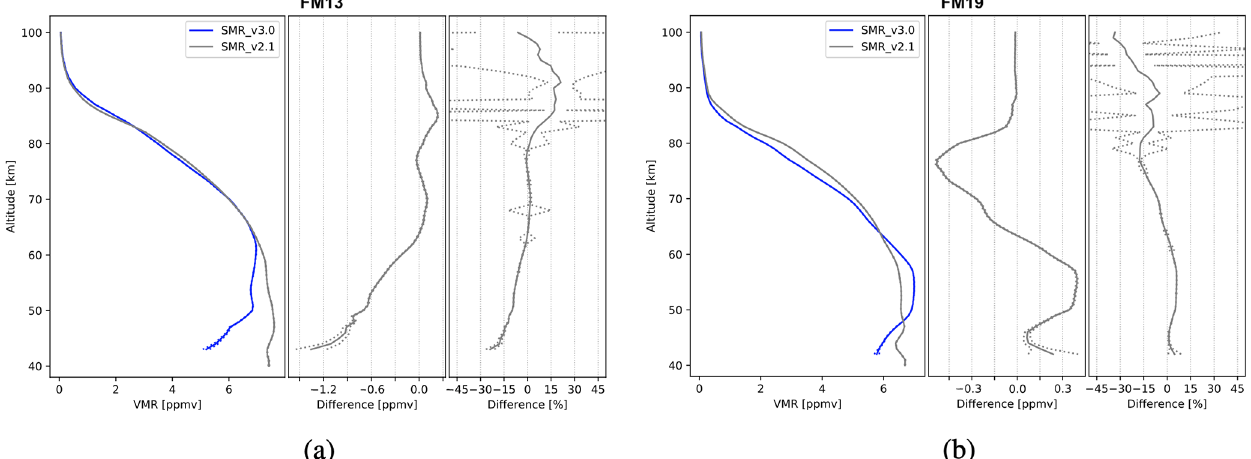
Figure 6. Comparison of SMR v3.0 with respect to v2.1 H 2 O profiles, from FM13 (a) and FM19 (b) . The data plotted are global averages over the time period between February 2001 and April 2019. Each subfigure consists of three panels. Left panels show volume mixing ratios, expressed in ppmv. Centre panels show absolute differences, expressed in ppmv. Right panels show relative differences, expressed in percentage. The differences shown are calculated as medians of the single profiles’ differences. The dashed lines represent the standard deviation of the median which, in some cases, is smaller than the thickness of the profile line, causing the dashed line not to be